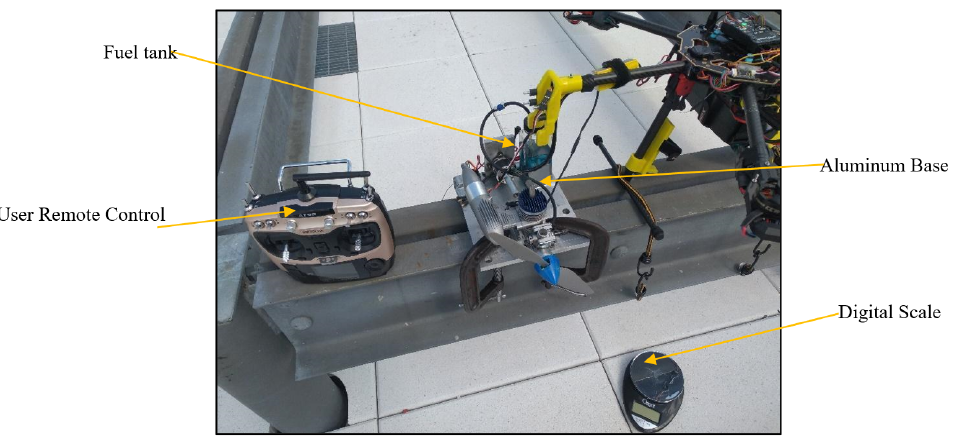
Figure 12. Gasoline engine test setup (RPM vs. fuel consumption